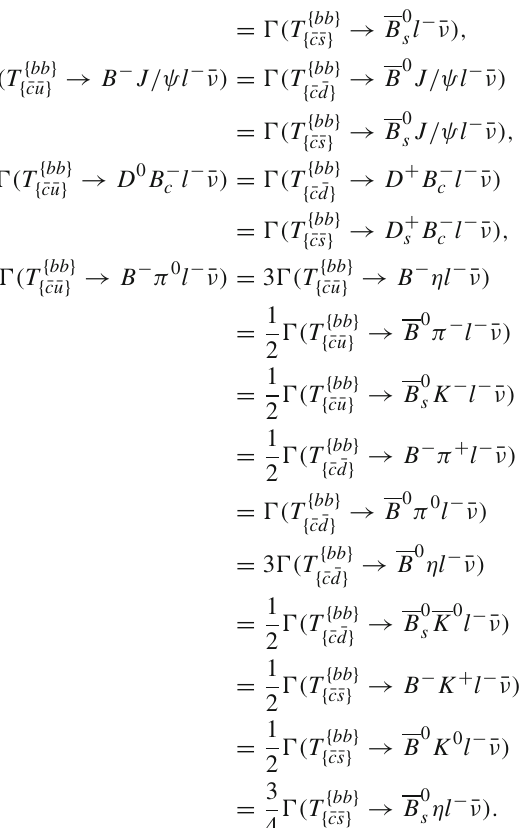
Fig. 2 The Feynman diagrams for the tetraquark T the processes of two mesons in final